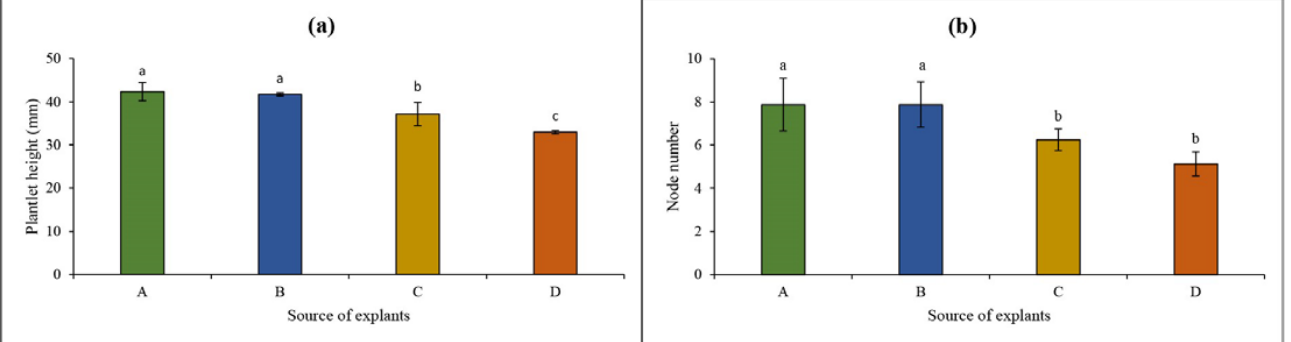
Figure 3. Single effect of the source of explants on ( a ) plantlet height and ( b ) number of nodes during in vitro multiplication of cannabis. Each value (column) shows the average of the explant source effect in all subcultures. Error bars represent standard error.